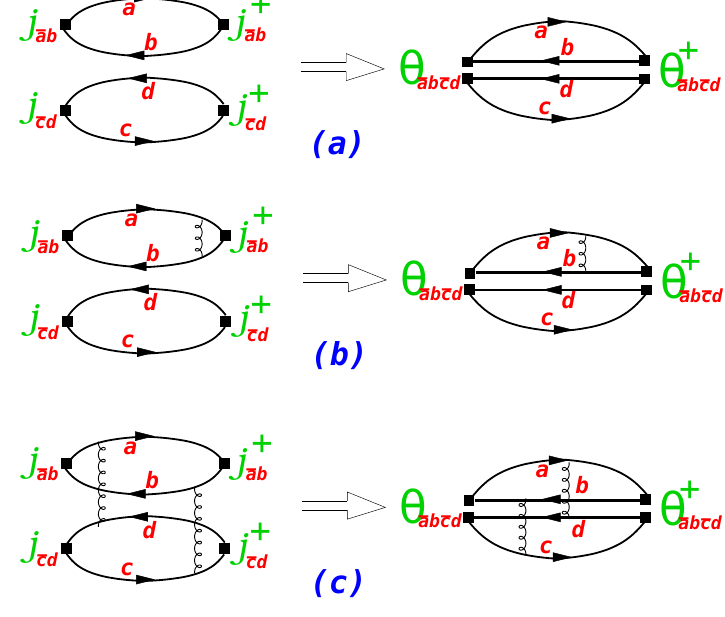
Figure 1. Flavour- preserving correlation function [6, 9]: representative examples of contributions of the three (a,b,c) lowest perturbative orders and their contractions to two tetraquark-interpolating operators θ .